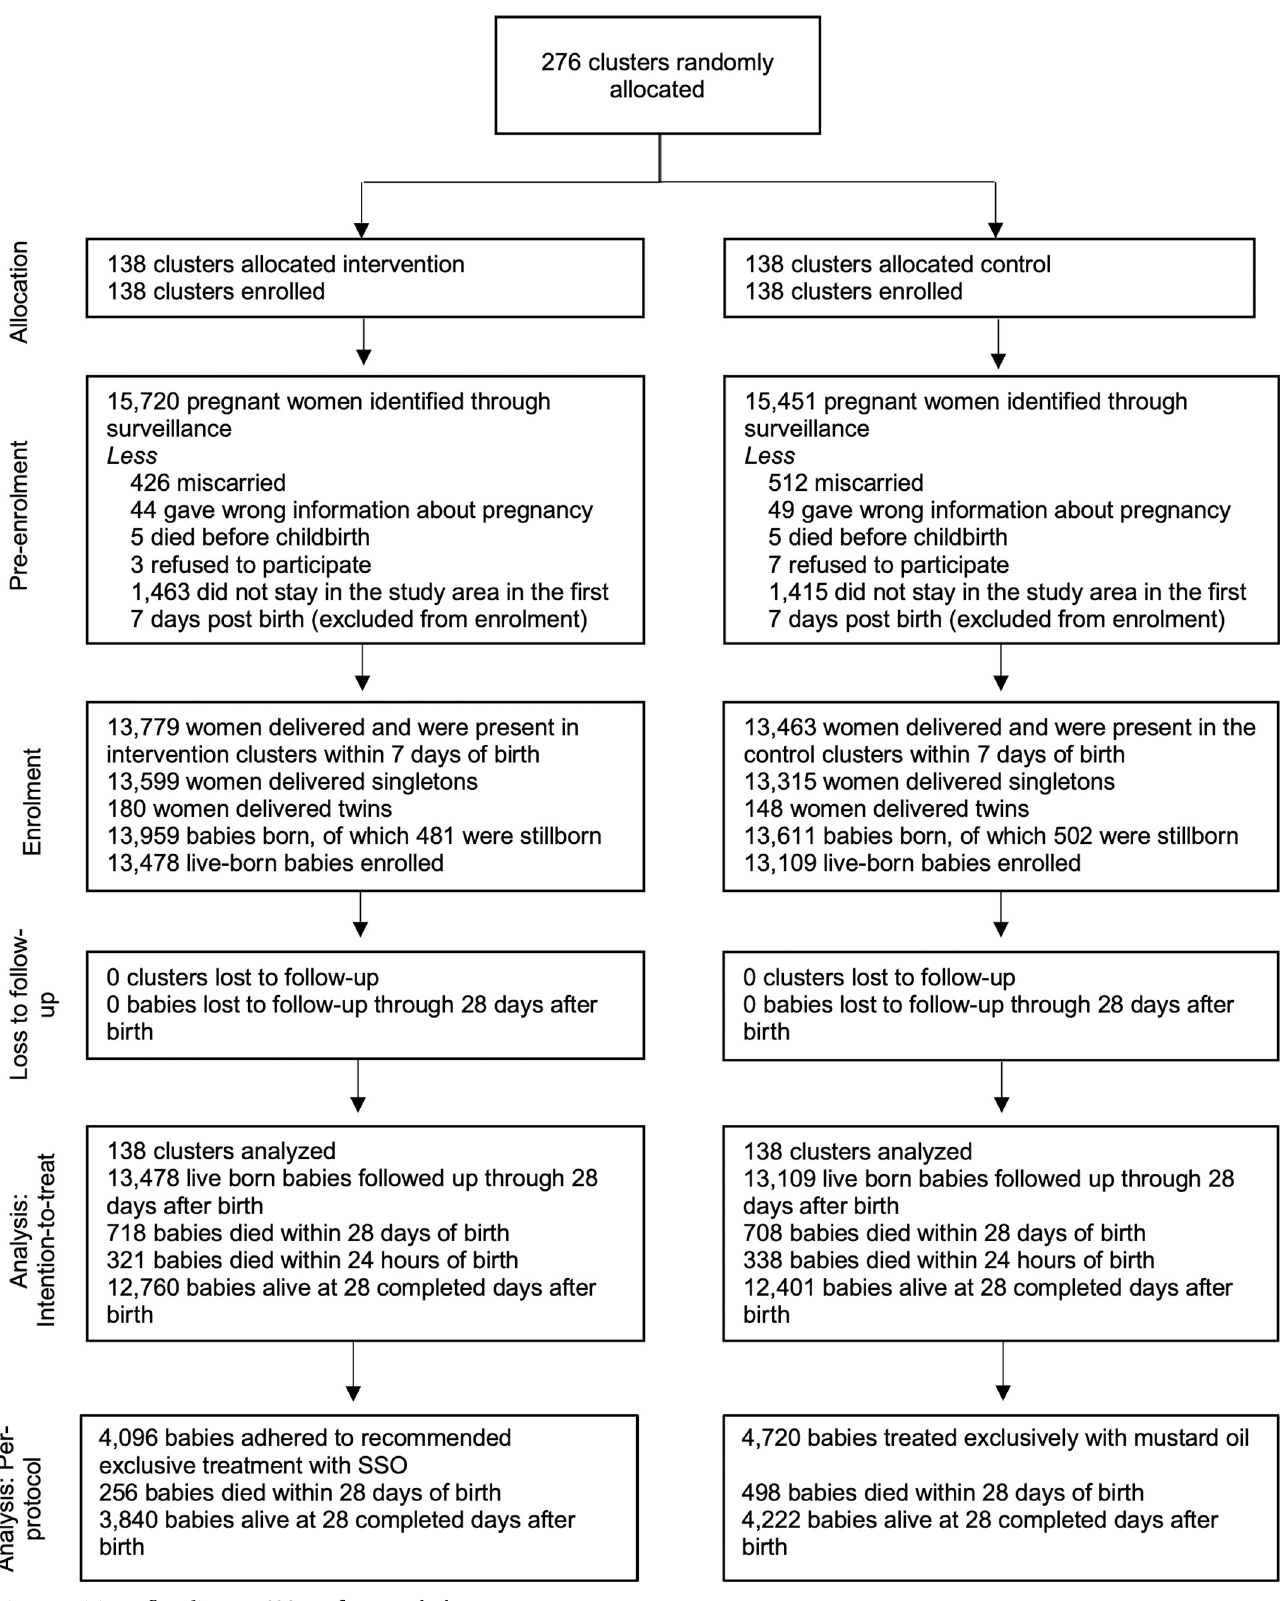
Fig 2. Participant flow diagram. SSO, sunflower seed oil. https://doi.org/10.1371/journal.pmed.1003680.g002 PLOS Medicine| https://doi.org/10.1371/journal.pmed.1003680 September 28,